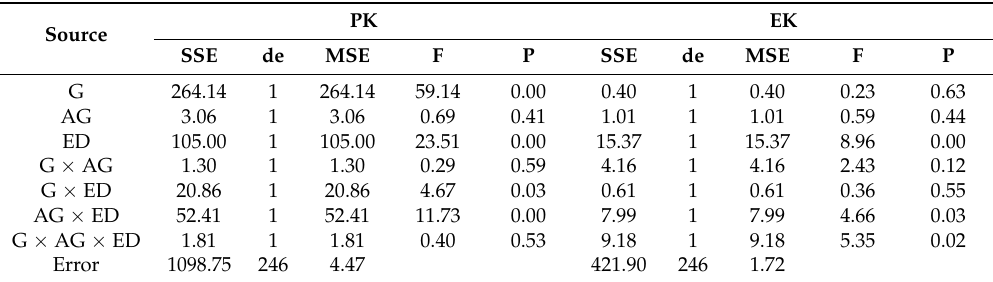
Figure 4. Contrasts of estimated marginal means of ( a ) plant knowledge; ( b ) environmental knowledge among different demographic groups. Only means with significant differences are shown. Table 4. Statistical results of ANOVA (Equation (1)) on the effects of gender (G), age (AG), and education (ED) on plant knowledge (PK) and environmental knowledge